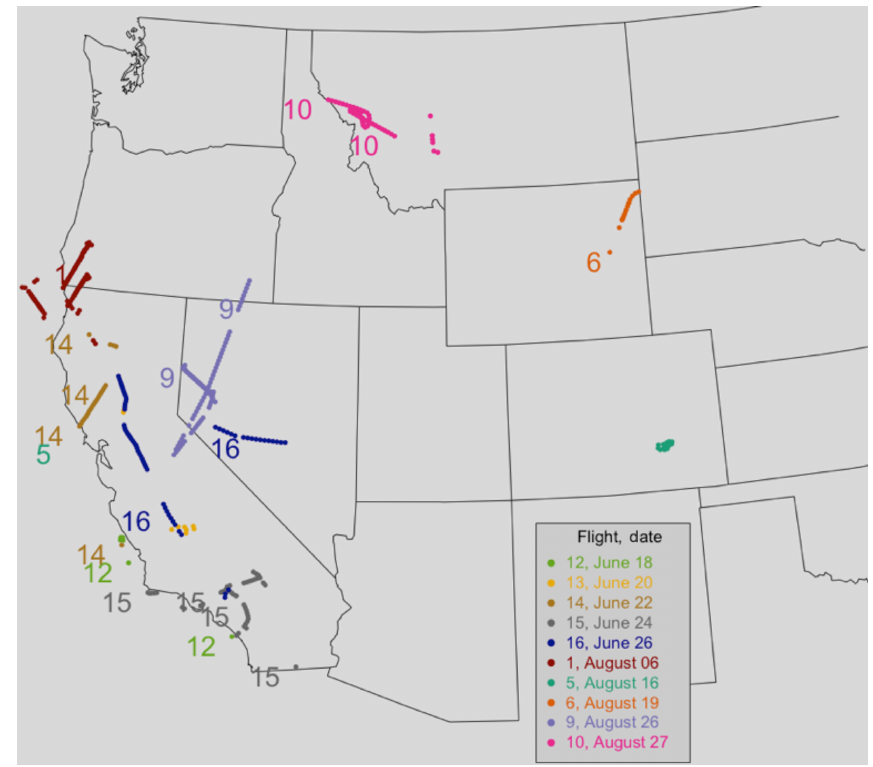
Figure 1. ARCTAS and SEAC4RS flights analyzed in this work. Each flight is identified by the flight number of that series. Flights 5 and 6 were in the Western USA but not